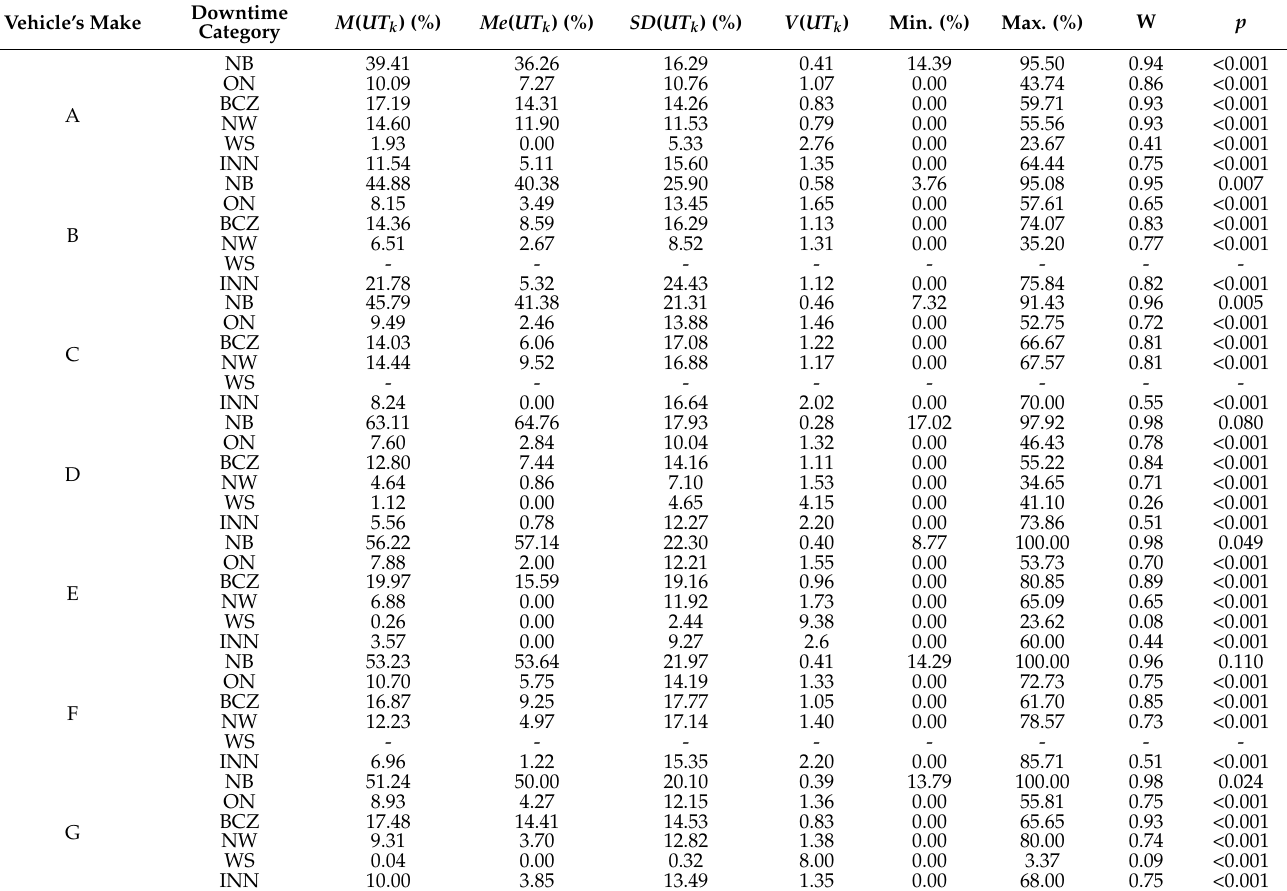
Table 3. Descriptive statistics of the categorized UT k availability and the result of the Shapiro–Wilk